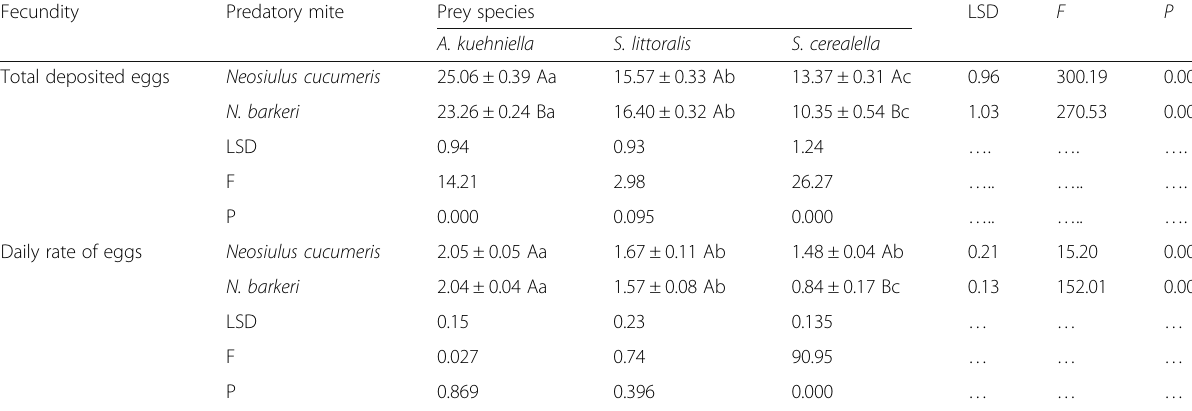
Table 5 Total and daily rate of deposited eggs of Neoseiulus cucumeris and N. barkeri fed eggs of Anagasta kuehniella , Spodoptera littoralis , and Sitotroga cerealella and incubated at 27 °C and 70% RH Fecundity